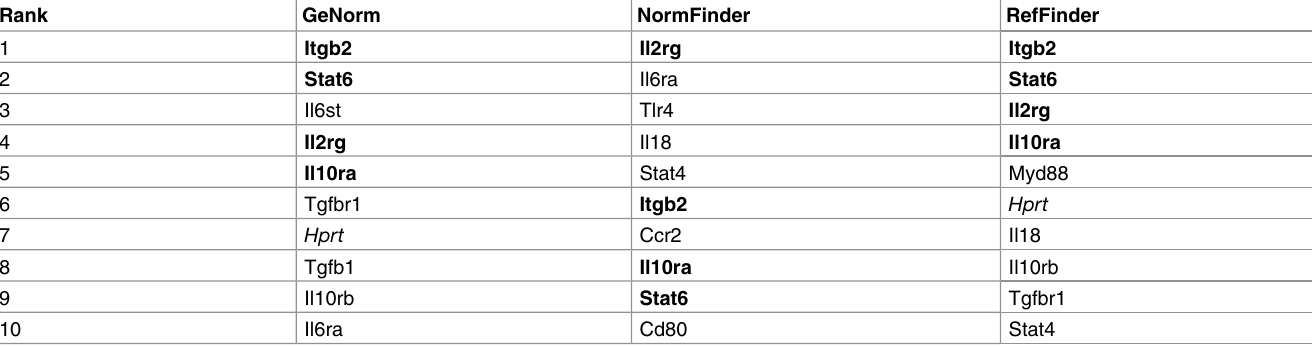
Bold letters indicate those genes that were identicalamong the top-tenby the three methods. Italics indicate “traditional”reference genes according to